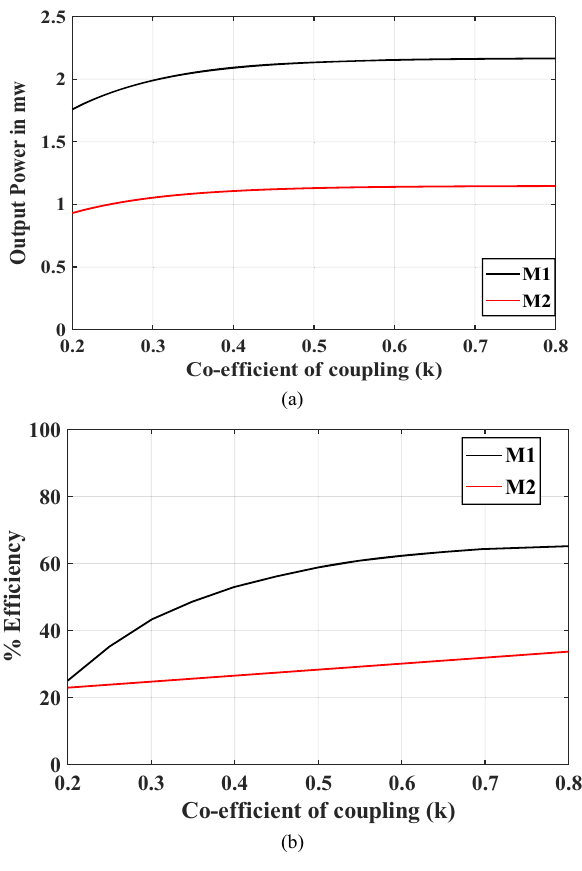
Figure 7: SS/PS topology: ( a ) change in e ffi ciency with respect to the coe ffi cient of coupling and ( b ) change in output power with respect to the coe ffi cient of